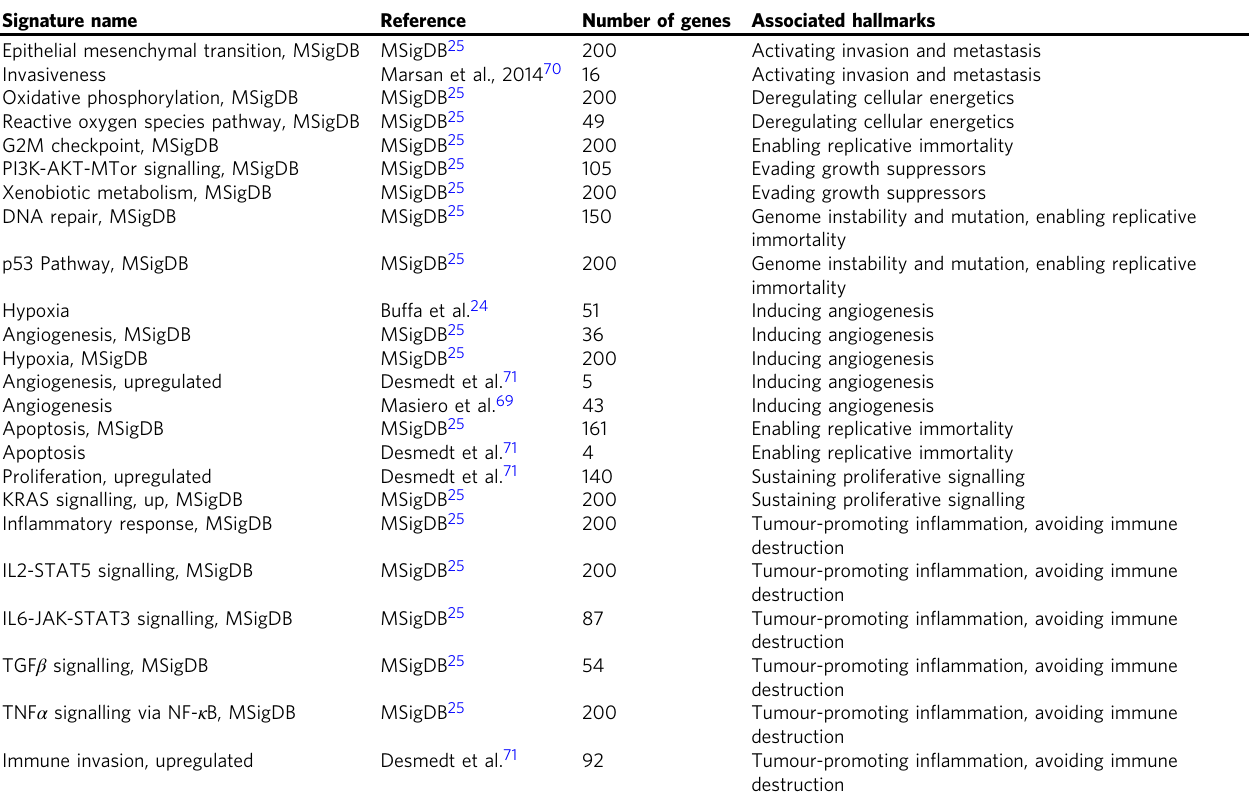
Table 1 Gene signatures considered and associated hallmarks of cancer